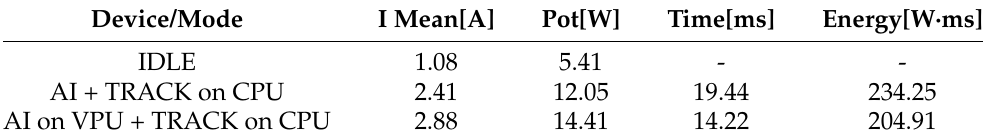
Table 5. Power and energy consumption values depending on the execution mode